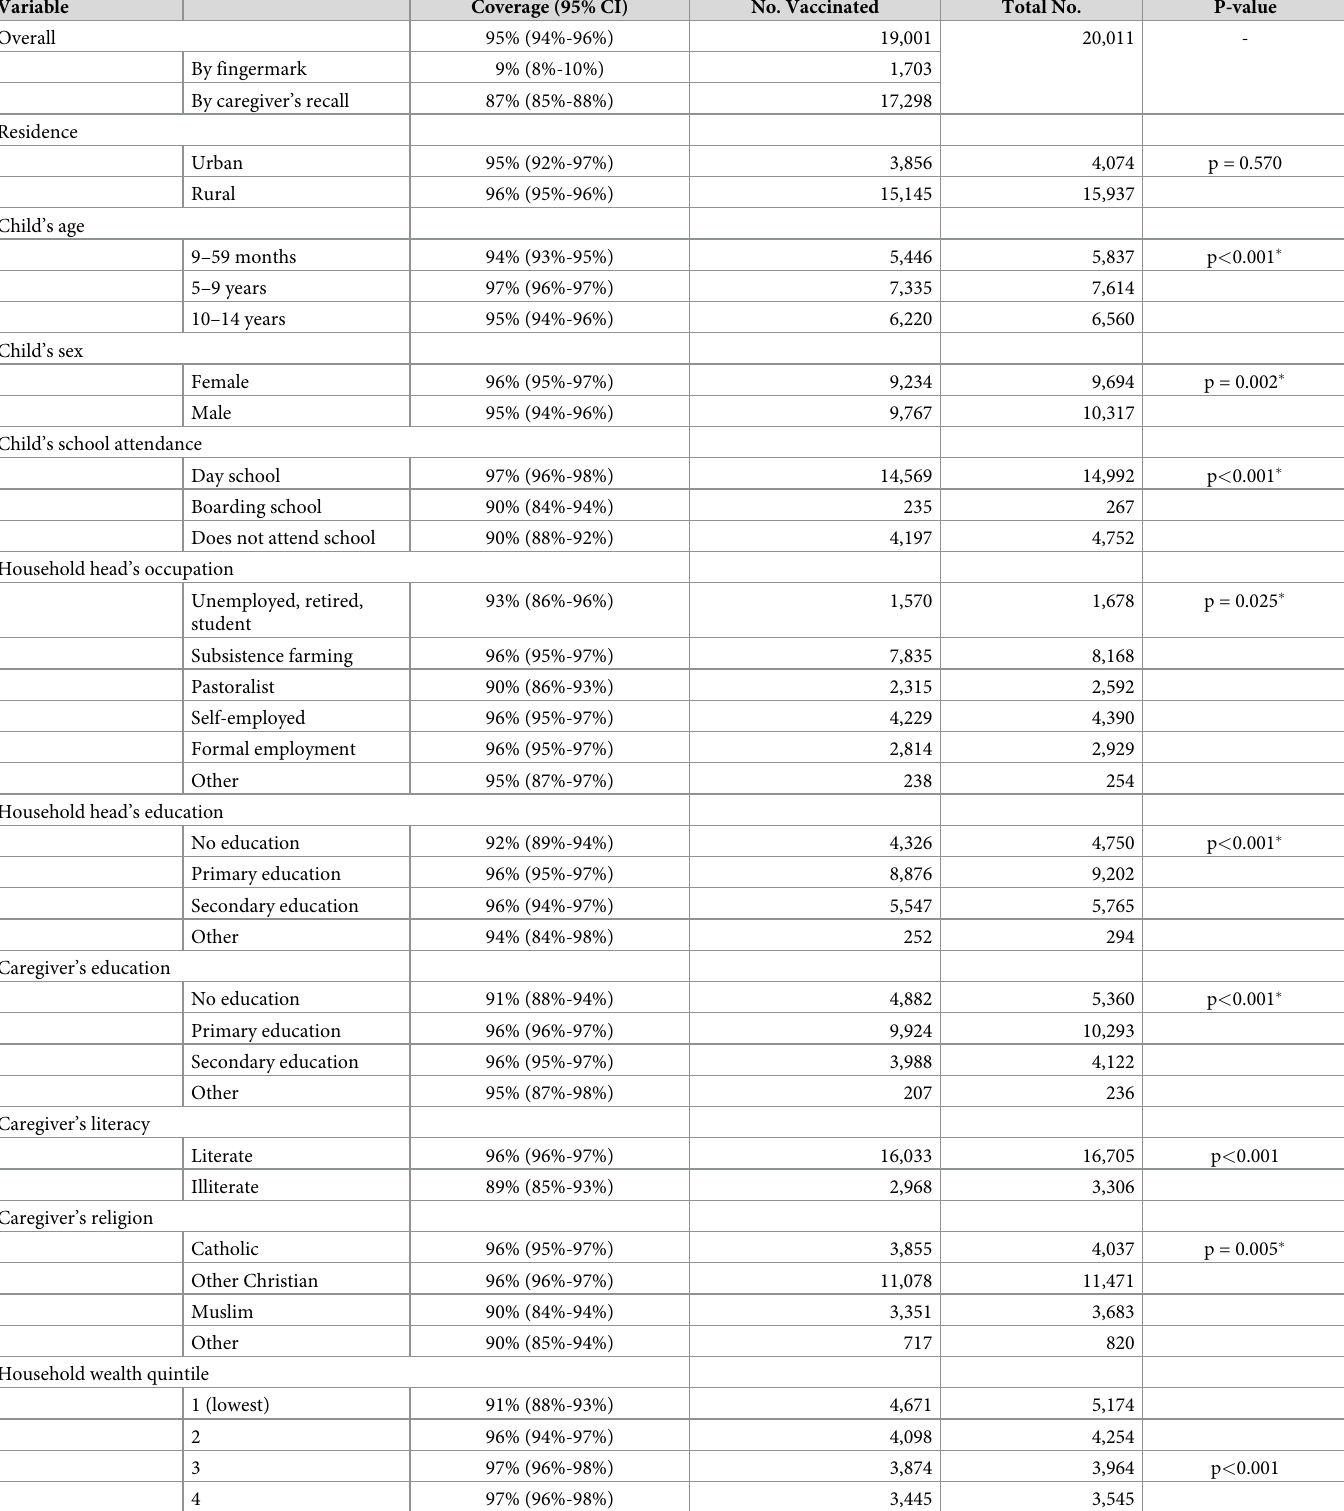
Table 2. Estimated measles-rubella campaign vaccination coverage overall and by subpopulation—Kenya, 2016.